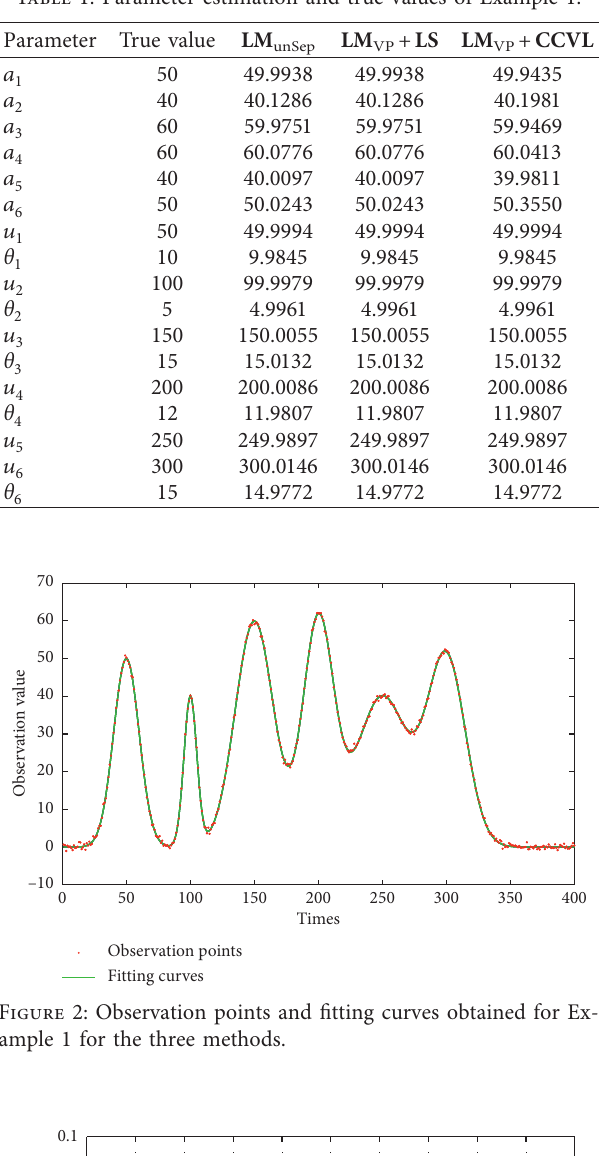
Table 1: Parameter estimation and true values of Example 1.